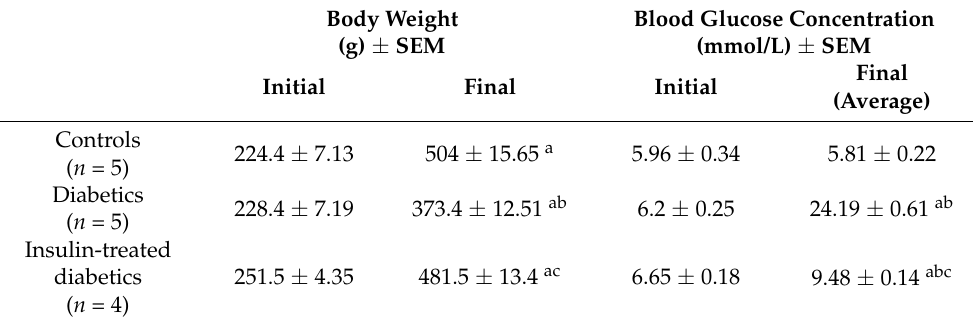
Table 1. Weight and glycaemic characteristics of the three experimental rat